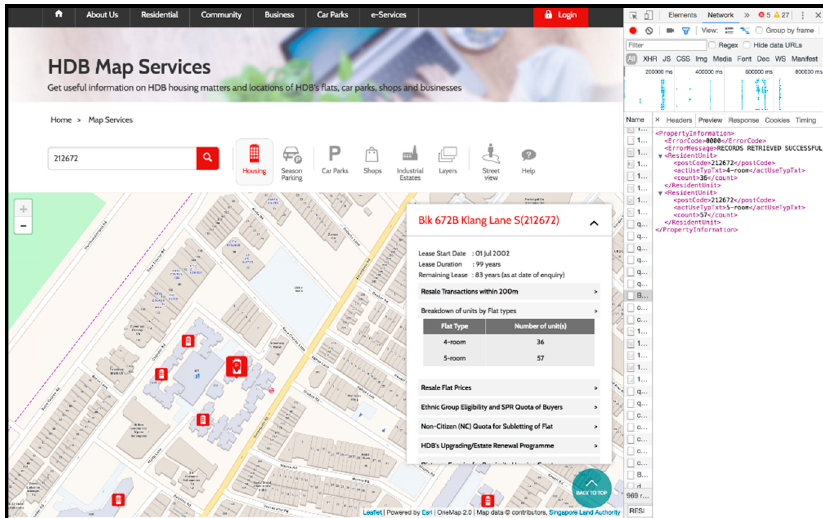
Figure 1. HDB’s map service that shows detailed information about each flat. In the screenshot, a HDB flat with postal code “212672” was selected and the popup showing its information is displayed.